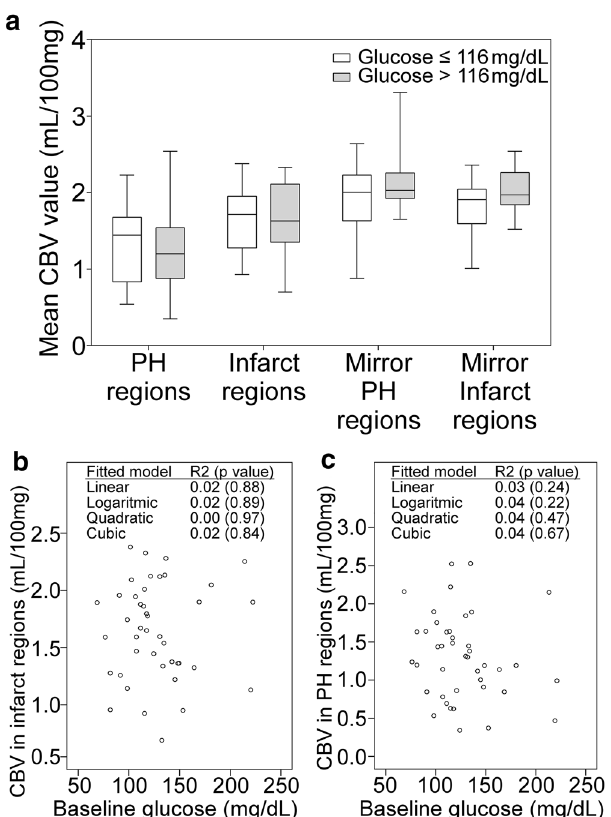
Figure 3. Cerebral blood volume values measured at pretreatment CTP in coregistered brain regions that developed PH or infarct at follow-up. ( a) Box-whisker plots of cerebral blood volume (CBV) values extracted from pretreatment computed tomographic perfusion (CTP) in coregistered regions that developed infarct or parenchymal hematoma (PH) at follow-up according to the presence or absence of pretreatment glucose levels higher than 116 mg/dL (6.4 mmol/L). ( b , c) Association between baseline glucose levels and CBV values extracted from pretreatment CTP in coregistered regions that developed infarct ( b ) or PH ( c ) at follow-up